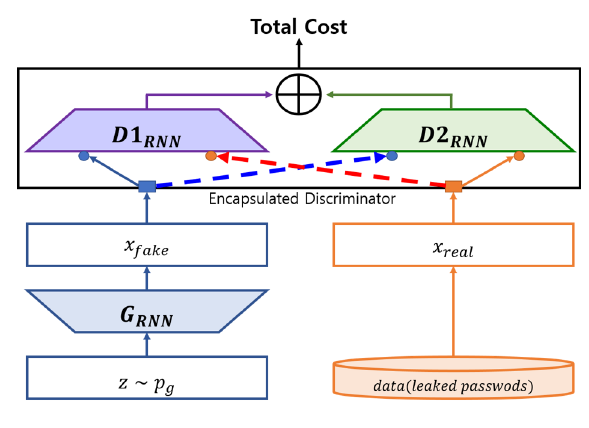
Figure 3. rPassD2CGAN showed some unstable training results. The use of different training data feeding modes stabilized rPassD2CGAN during training.